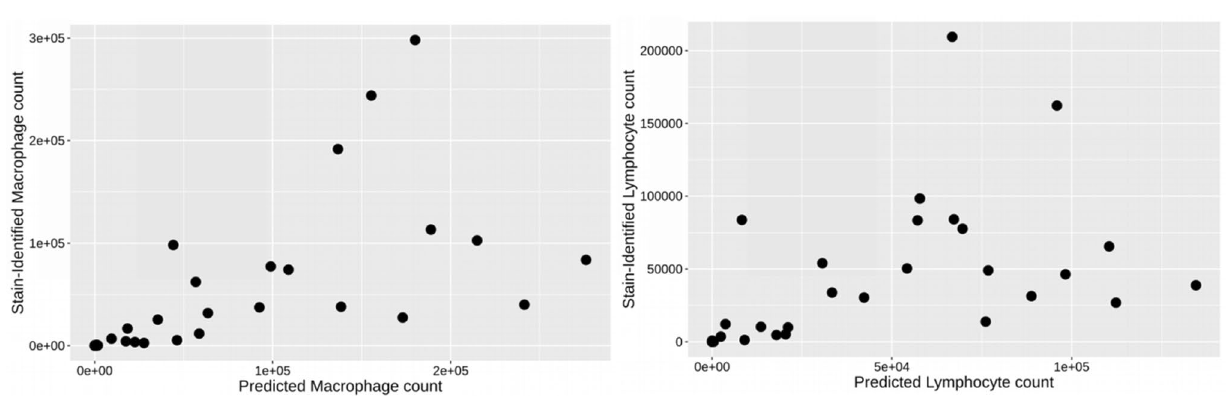
Figure 3. Comparison of immune cell predicted counts vs immunofluorescence counts. Comparison between counts of algorithm-predicted macrophages and lymphocytes vs. counts of staining-identified cells of the same